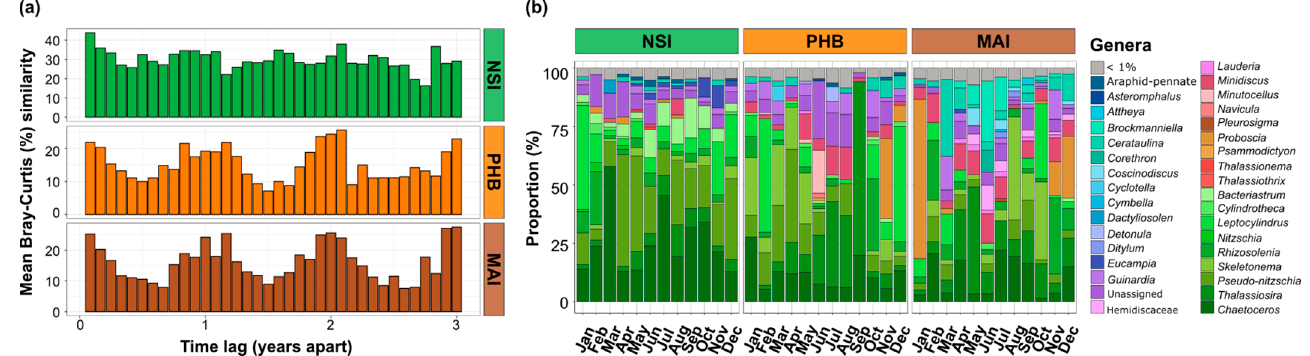
Figure 5 . Interannual Variability of Diatom Communities (a) and Temporal Marine Diatom Com- position (b). ( a ) Mean Bray-Curtis similarities of all-pairs samples separated by a given numbers of months apart. The first bar represents the mean Bray-Curtis similarity between samples that are one month apart, the second bar the mean Bray-Curtis similarities between samples that are two months apart (etc.). ( b ) Temporal community composition of the most abundant marine diatoms genera (>1% threshold) in the surface waters (2 m) at Maria Island, Port Hacking and North Stradbroke Island NRS sites across all sampling times between 2017 and 2019. Relative abundance represents the average relative abundance (surface water) of each month across the three years (2017–2019). The full dataset is presented in Figure